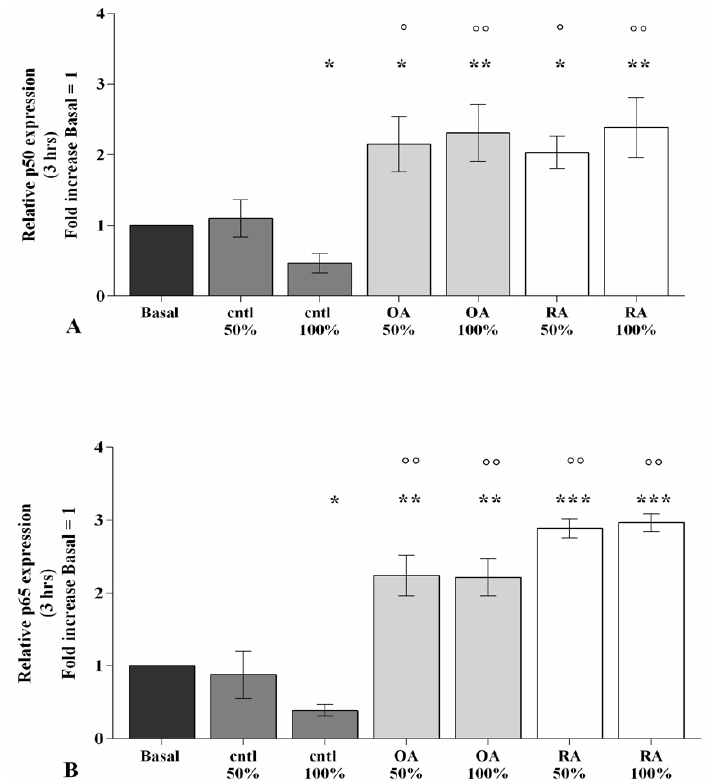
Figure 6. SF modulates the NF- κ B signaling pathway. Human osteoarthritic (OA) chondrocytes were incubated for 3 h with 50% and 100% SF derived from patients with OA, rheumatoid arthritis (RA), or controls. ( A , B ) Expression levels of p50 and p65 subunits analyzed by quantitative real-time PCR. The gene expression was referenced to the ratio of the value of interest and the value of the basal condition, reported equal to 1. Data were represented as mean ± SD of triplicate values. * p < 0.05, ** p < 0.01, *** p < 0.001 versus basal condition. ◦ p < 0.05, ◦◦ p < 0.01 versus control SF.